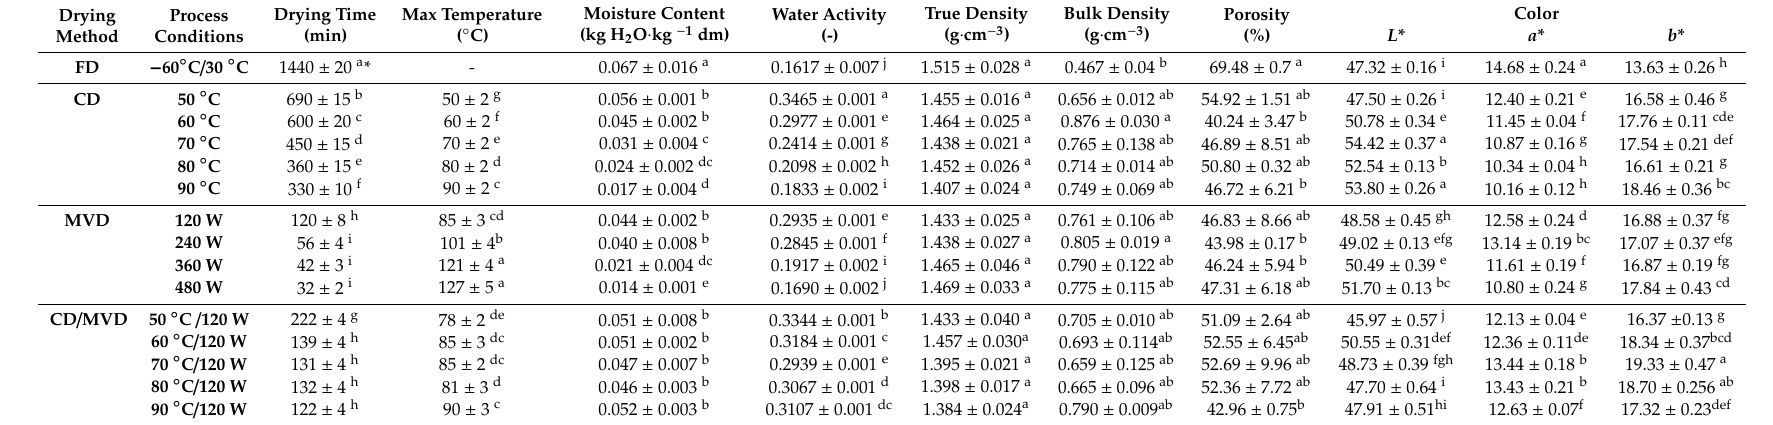
Table 2. Physical properties of dried plum pomace obtained using selected drying